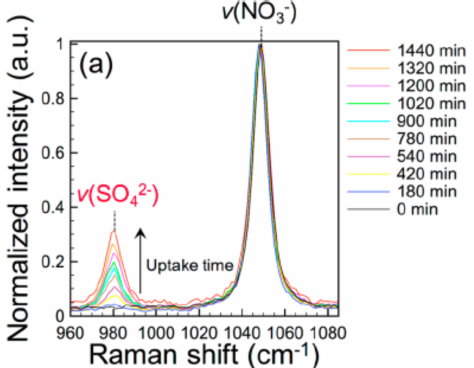
Figure 4. Sulfate formation during the photolysis of AN particles in the presence of SO 2 at 80%RH (Gen et al.,